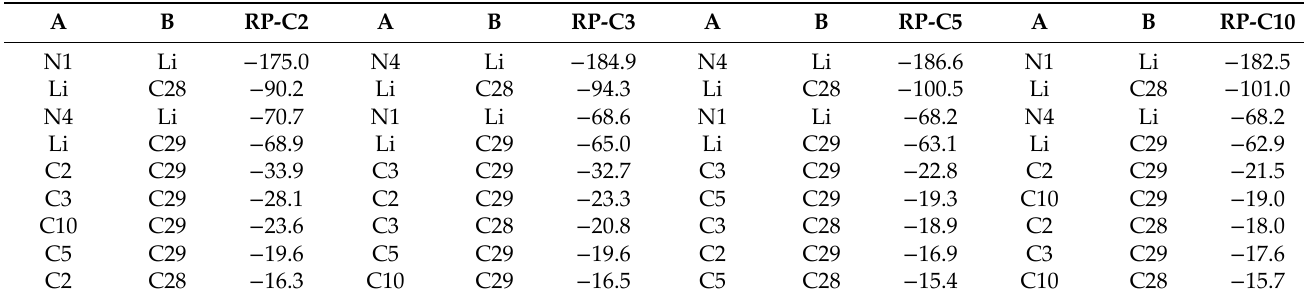
Table 1. Most significant (leading) attractive diatomic intermolecular interactions in the adducts formed between 1 and 2 along the four potential RPs. All values are given in kcal mol − 1